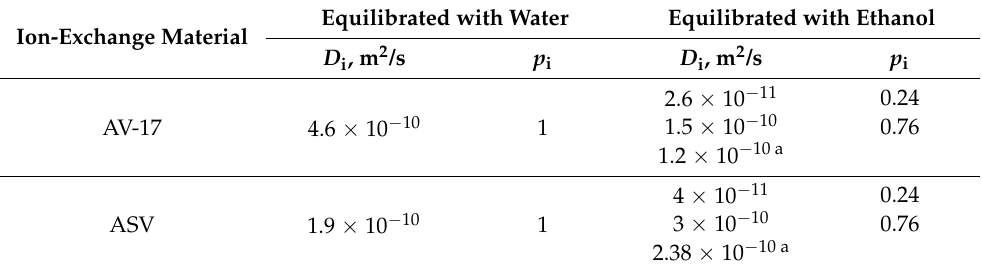
Table 11. Self-diffusion coefficients of water and ethanol ( D i ) at 293 K and relative values p i of the diffusant in different regions of the ion-exchange materials in the F − form equilibrated with water or